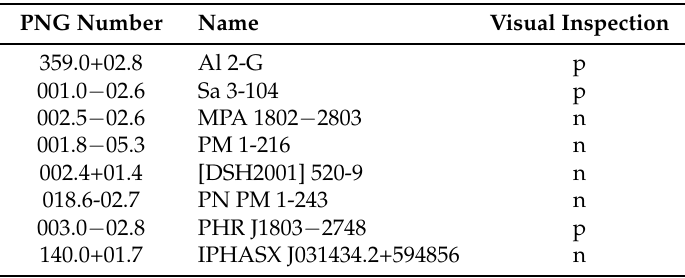
Table 9. Rejected objects classified here as True PN. In the last column, ‘p’ indicates a potential PN while ‘n’ suggests a negative classification. PNG Number Name Visual